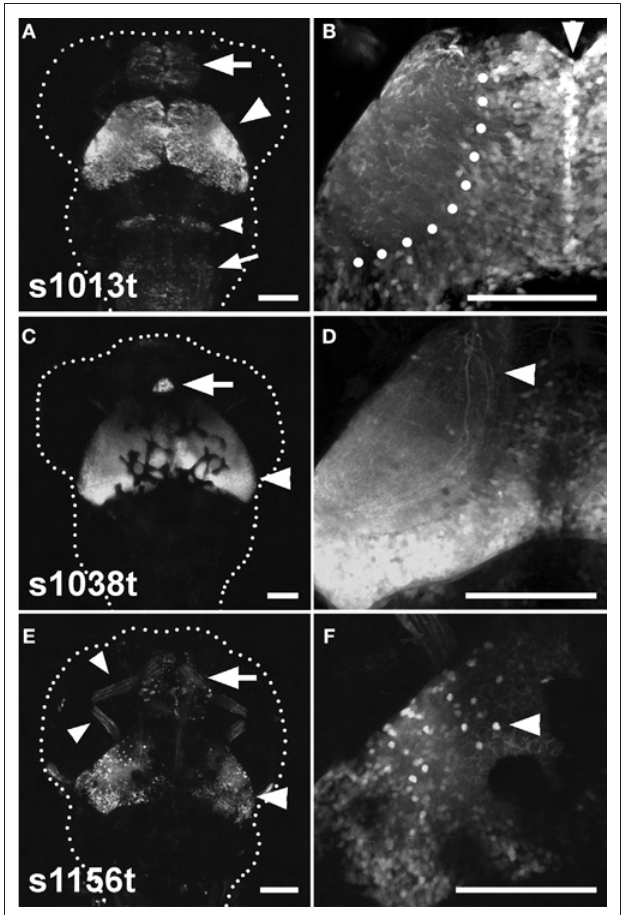
FiGUrE  | Three tectal lines arising from the ET screen. (A) , (C) , and (E) show dorsal images of 5-dpf larvae, anterior at the top. A dotted line indicates the approximate boundary of the animal. (B) , (D) and (F) contain corresponding high-magnification images of the left tectum in the same ET line. (A) Shows the s1013t expression pattern. Expression is seen primarily in the tectum (arrowhead), but also in the pallium (arrow), the hindbrain (small arrowhead) and the medulla oblongata (small arrow). Expression in the tectum is strong and spread evenly across the A-P and M-L axes (B) . The midline (arrowhead) and boundary between the tectal cell body layer and neuropil (dotted line) are indicated in (B) . s1038t (C) has strong expression in the tectum (arrowhead) and pineal (arrow). Expression in s1038t is strongest in the posterior tectum (D) , and axons from s1038t -positive neurons are seen extending beyond the tectum (arrowhead). (E) Shows s1156t expression in the tectum (arrowhead), forebrain (arrow), and ocular muscles (small arrowheads). As compared to the other lines, s1156t is expressed in a smaller subset of tectal neurons (F) , and is prominent in cell bodies located at the superficial surface of the tectal neuropil (arrowhead). Scale bars in all panels indicate 100 μm. Animals are heterozygous both for the indicated Gal4 insertion and UAS:Kaede .